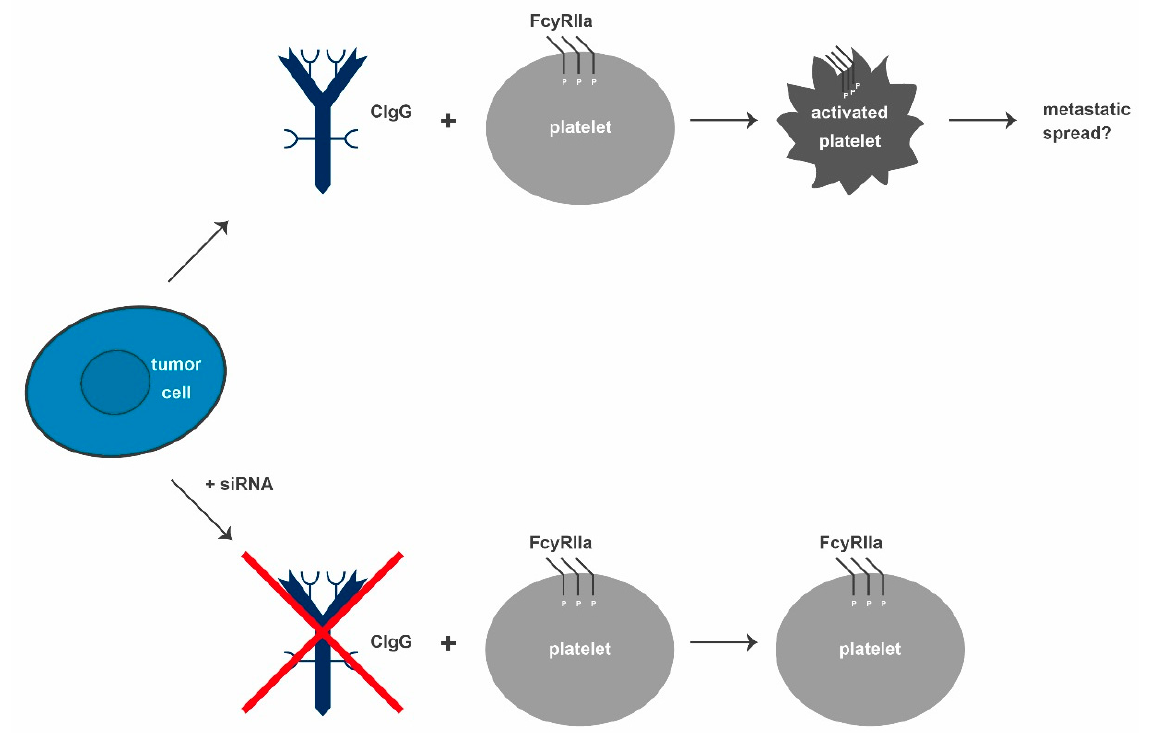
Figure 4. CIgG can bind to Fc γ RIIa on inactivated platelets and thereby increase phosphorylation levels. As a result, the platelets are activated and function as tumor progression facilitators in different ways. In addition, the metastasizing potential of tumors is reported to increase due to activated platelets. Blocking CIgG inhibits the CIgG-mediated platelet activation. CIgG: cancer-derived IgG, siRNA: small interfering RNA.